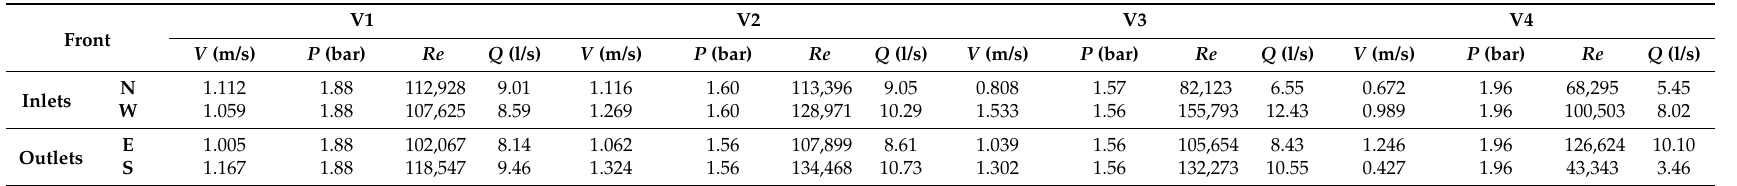
Figure 5. Boundary velocities for experiments. Table 2. Contents values of the four scenarios V1 to V4